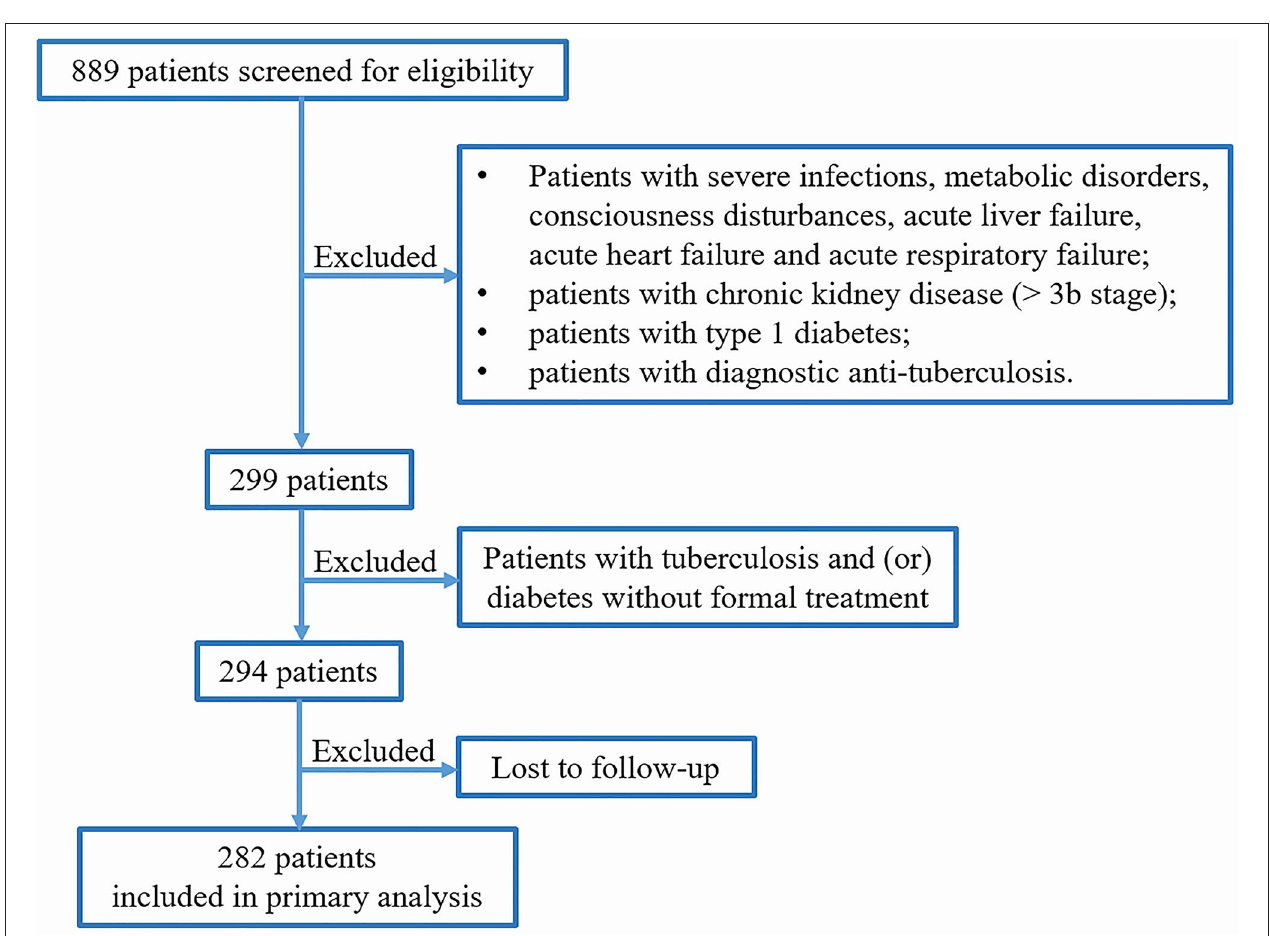
FIGURE 1 | Flow diagram of the selection of patients for